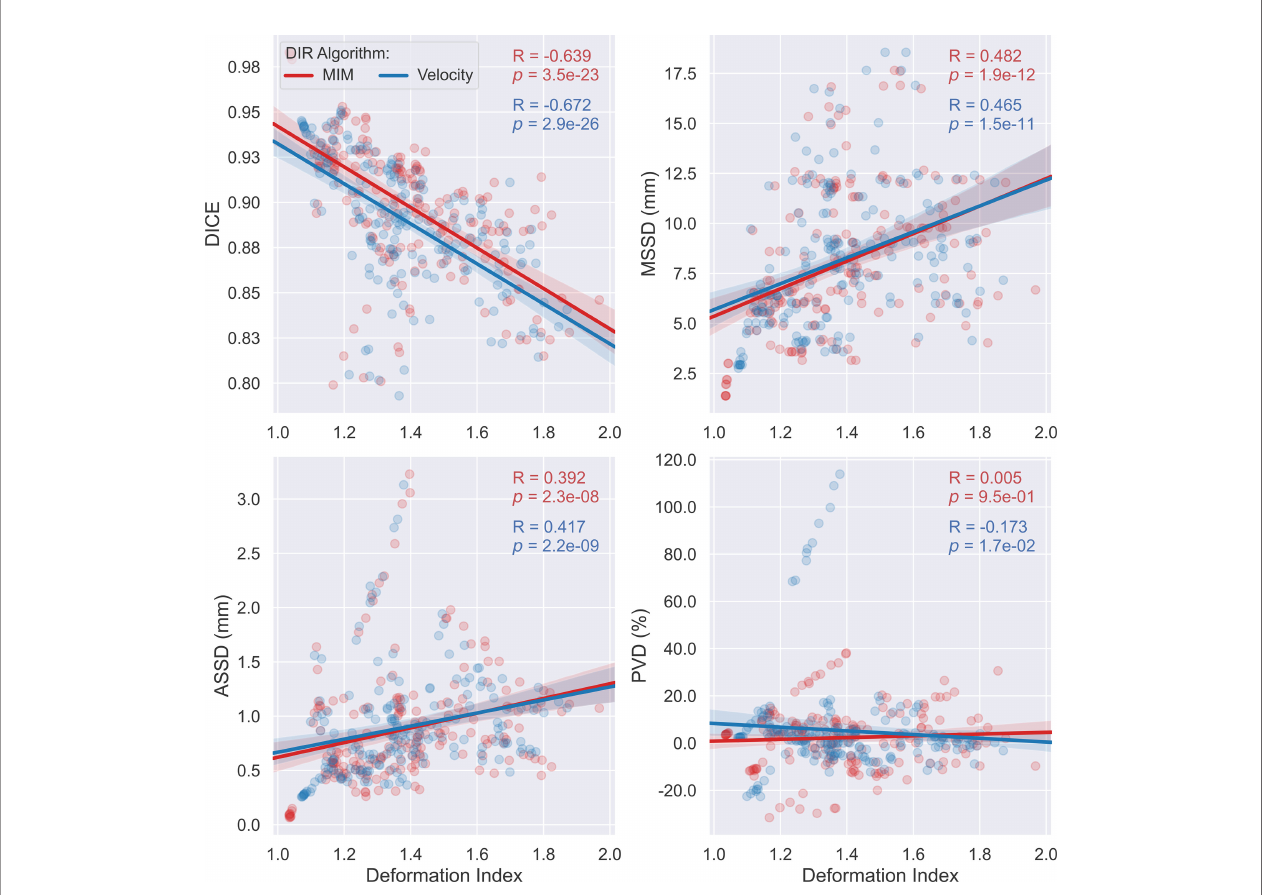
FIGURE 6 | Scatter plots with linear regression (95% con fi dence intervals of the predicted mean) outlining the distribution of Dice coef fi cient (DICE), maximum symmetric surface distance (MSSD), average symmetric surface distance (ASSD), and percent volume difference (PVD) versus the deformation index for the two employed deformable image registration (DIR) algorithms — MIM (red) and Velocity (blue). Each dot corresponds to a different single respiratory phase for one individual